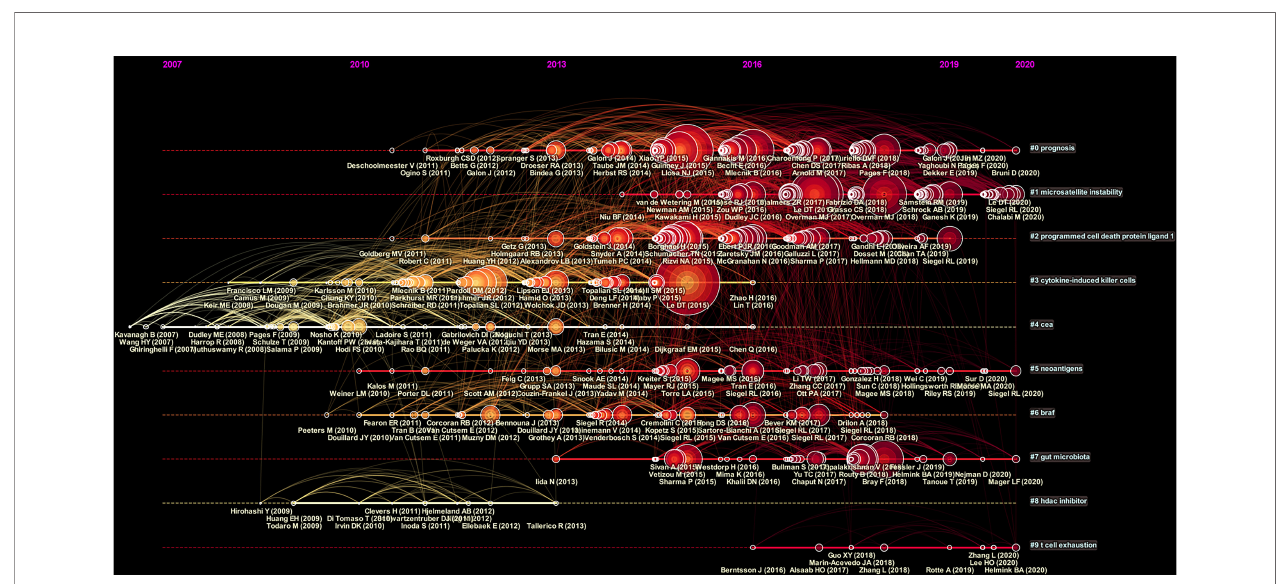
FIGURE 6 | A timeline view for co-cited references associated with colorectal cancer immunotherapy. The node ’ s position on the horizontal axis represents the time when the reference fi rst appeared, and the node ’ s size is positively correlated with the number of citations of the reference. The lines between the nodes represent co-cited relationships. The redder the color means closer to 2021, and the more yellow the color means closer to 2012.The clusters with redder colors and larger nodes included more publications, demonstrating that the issue of this cluster was a hot topic in the fi eld.